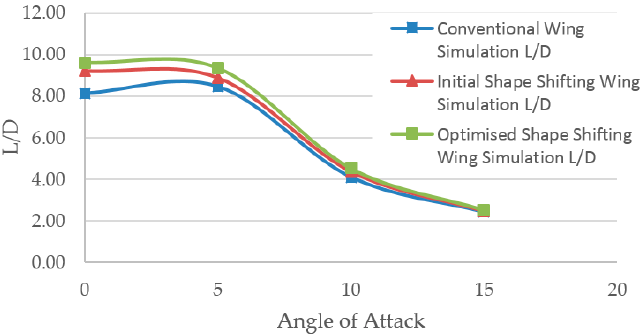
Figure 22. A graph showing lift-to-drag ratios or glide ratios for all three wings.